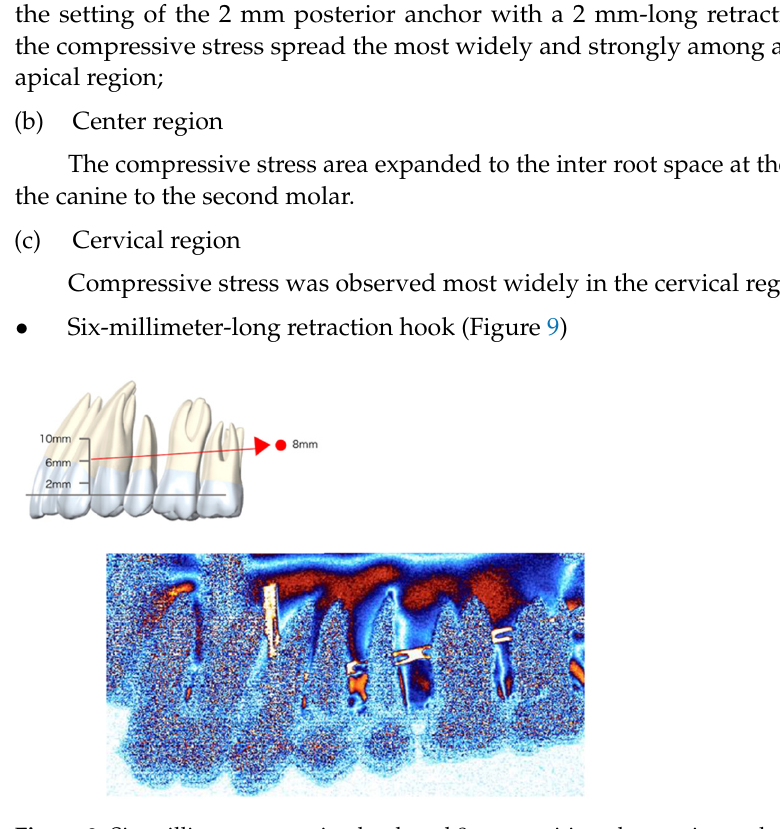
Figure 9. Six-millimeter retraction hook and 8 mm positioned posterior anchor model.